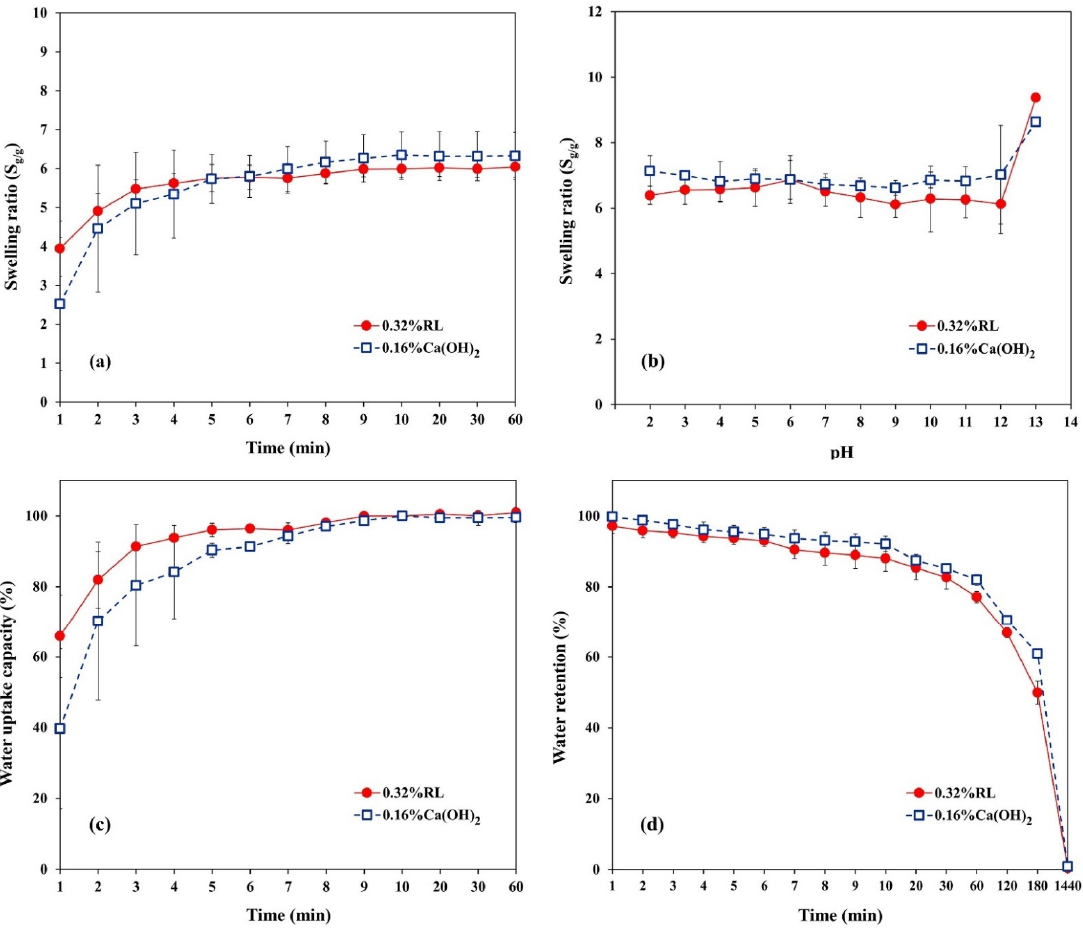
Figure 7. Swelling behavior of the cryogels prepared using 0.32% RL and 0.16% Ca(OH) 2 ( n = 3) ( a ) swelling ratio, ( b ) effects of pH, ( c ) water uptake capacity, and ( d ) water retention.